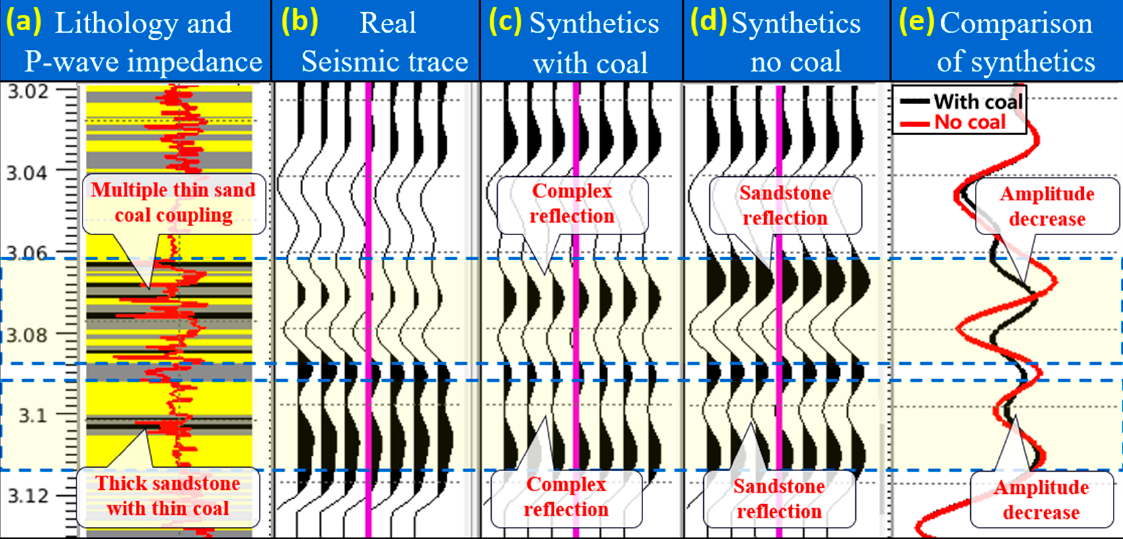
Figure 14. Lithologic results of well logs and comparison of seismic records: ( a ) lithology and P-wave impedance, ( b ) real seismic trace, ( c ) synthetics with coal, ( d ) synthetics without coal, and ( e ) comparison of synthetics.